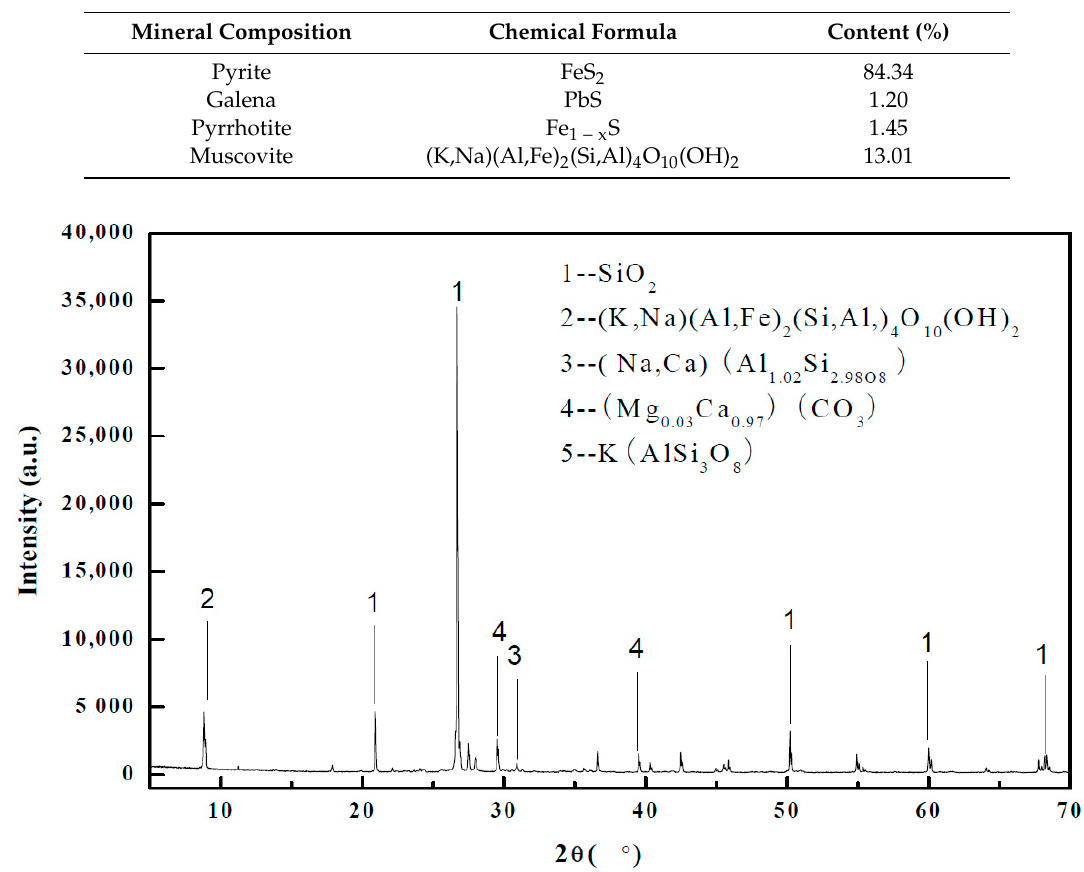
Figure 9. XRD detection and analysis of concentrate composition. Table 5. Mineral composition content of concentrate.